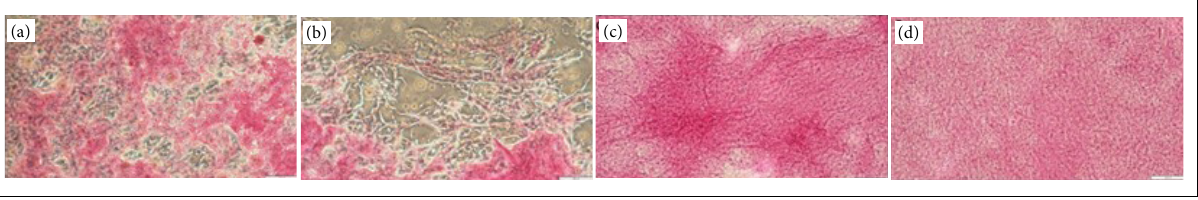
Figure 6 - Hydrogel stained with picrosirius. ( a and b ) Hydrogel from in-natura skin with thicker and more condensed collagen fibers in comparison to hydrogel from decellularized skin, which ( c and d ) contain more spread collagen